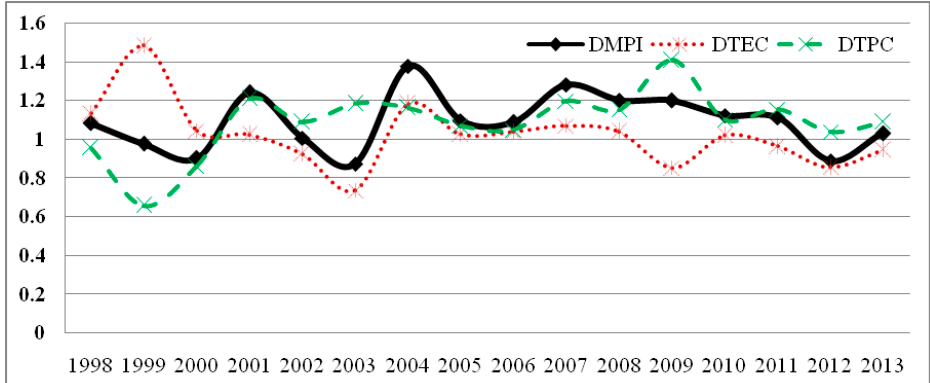
Figure 2. Decomposing foreign directed investment (FDI) dynamic performance in China.